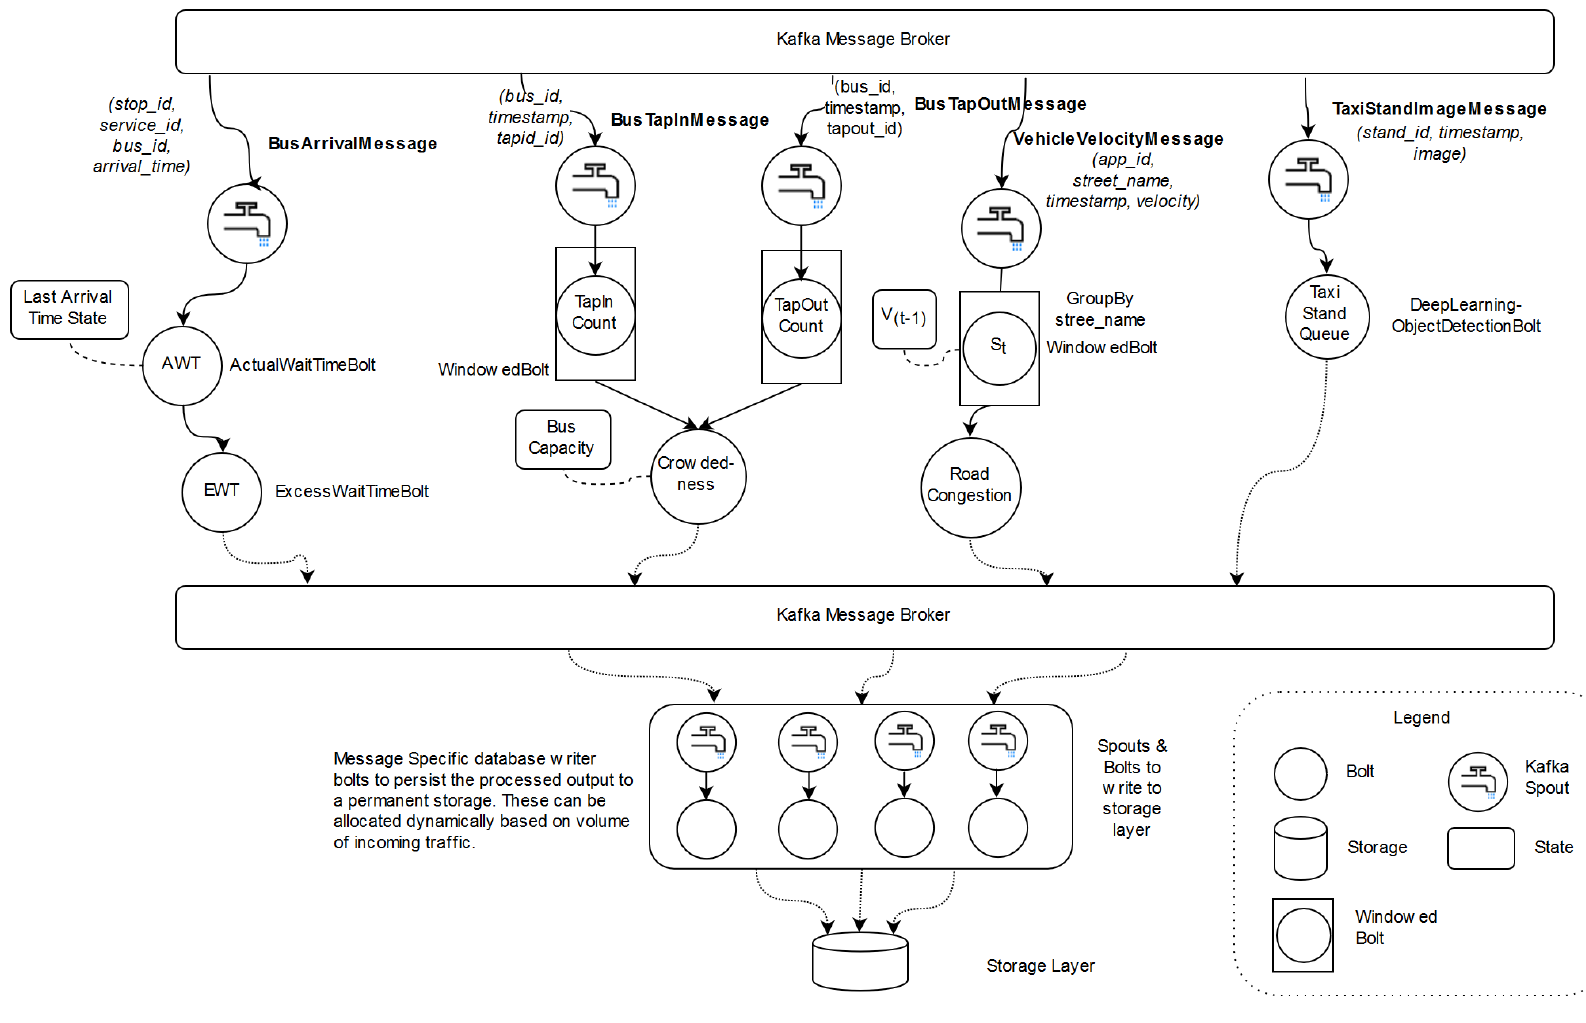
Figure 4. Overview of Storm topology of MOBDA for real-time transport service metrics.